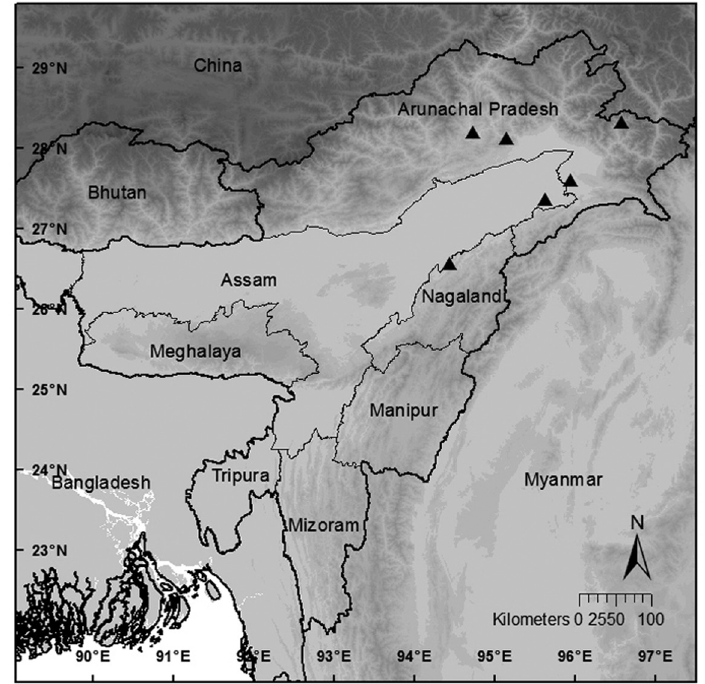
Fig. 50. Map showing the location of B. rex Putz.